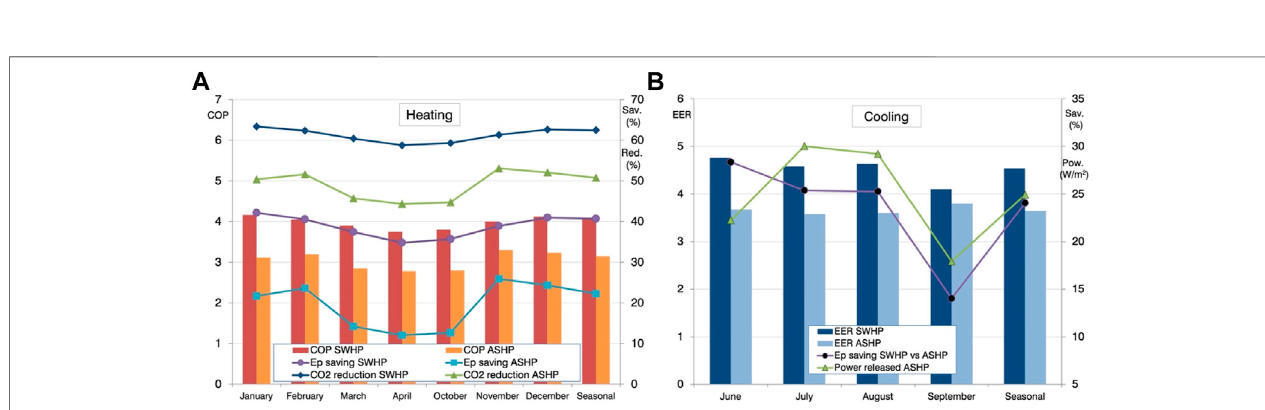
FIGURE 12 | Monthly and seasonal COP/EER of HPs during heating season (A) or cooling season (B) . In winter, both savings compared to using condensing boilersand CO 2 reductions.In summer,the savingsare withSWHPs compared tothosewithASHPs.The average speci fi cheatpower released byASHPs in theareais also given in panel (B) .